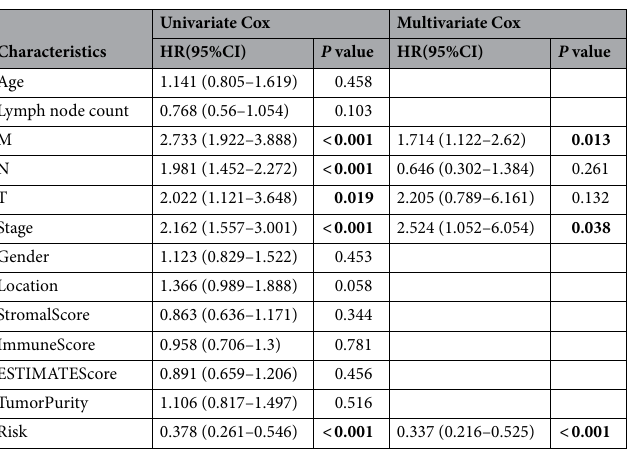
Table 2. Univariate and multivariate Cox analysis of the clinicopathological features and signature with OS. Significant values are in